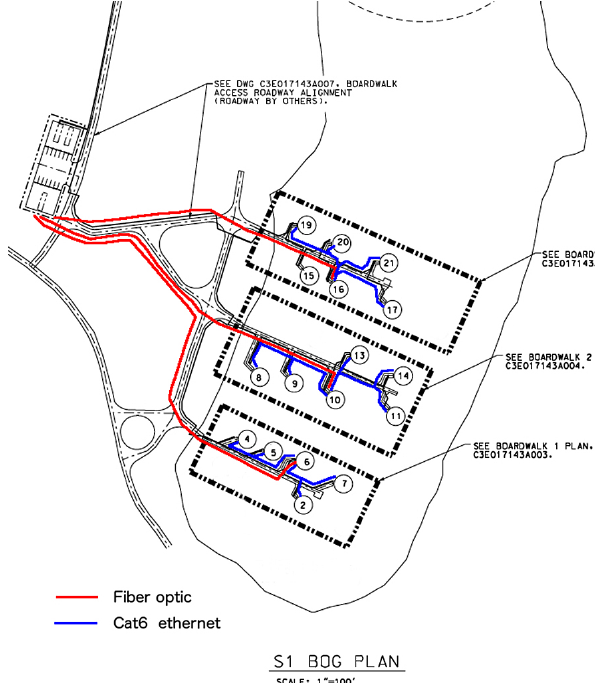
Figure 4. Network